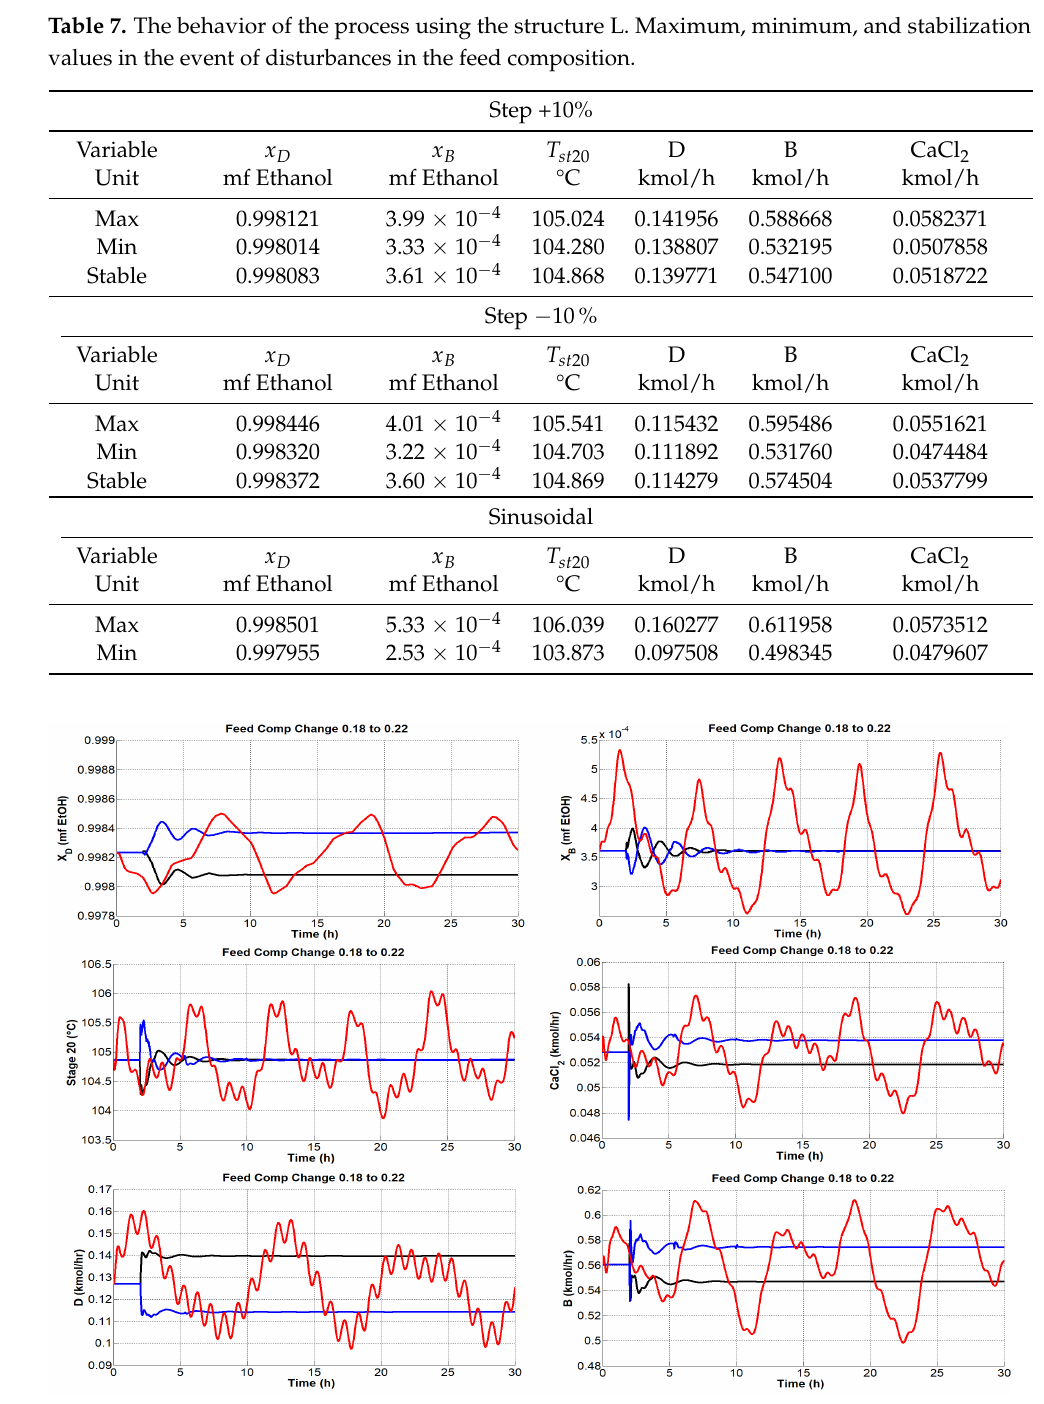
Figure 13. The behavior of structure L with changes in the main feed in a stepwise form of 10% mf ( black ) and − 10% mf ( blue ), also sinusoidal changes in the mole fraction ( red